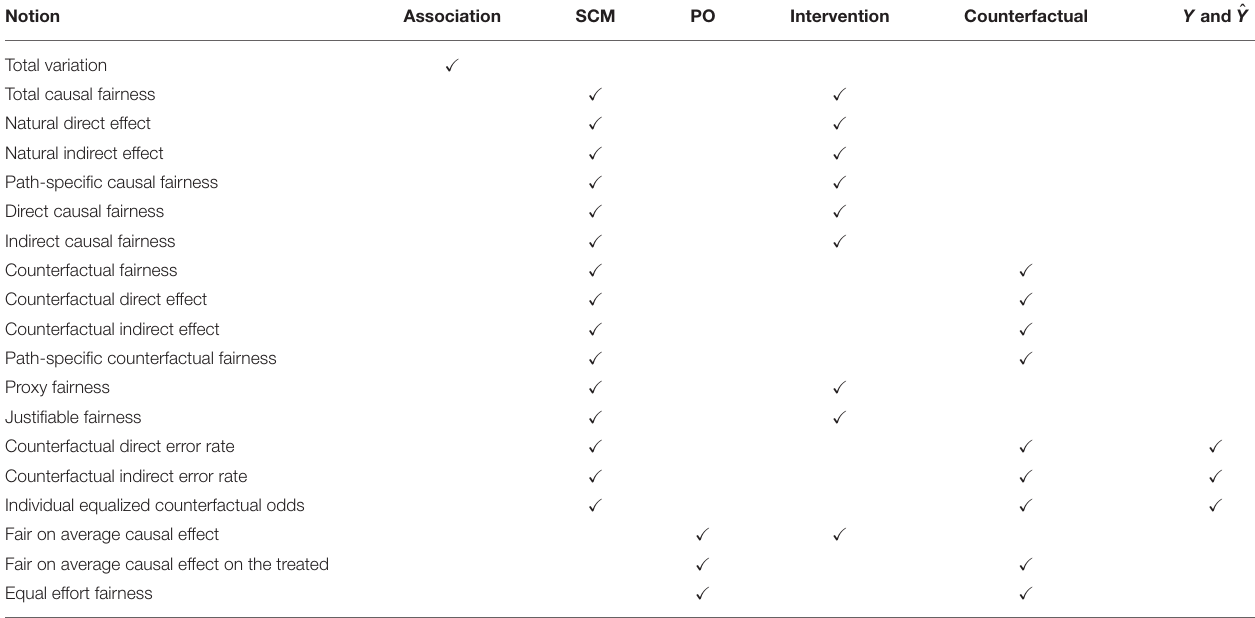
TABLE 1 | Classification of causality-based fairness notions. Notion Association SCM PO Intervention Counterfactual Y and ˆ Y